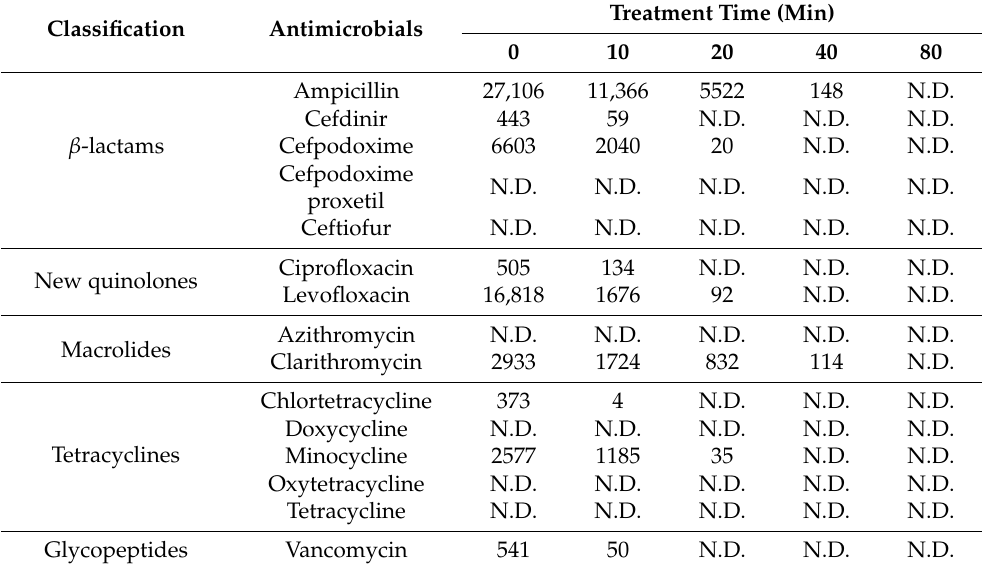
Table 2. Concentrations of targeted antimicrobials in hospital wastewater during ozone treatment (N.D.: Not